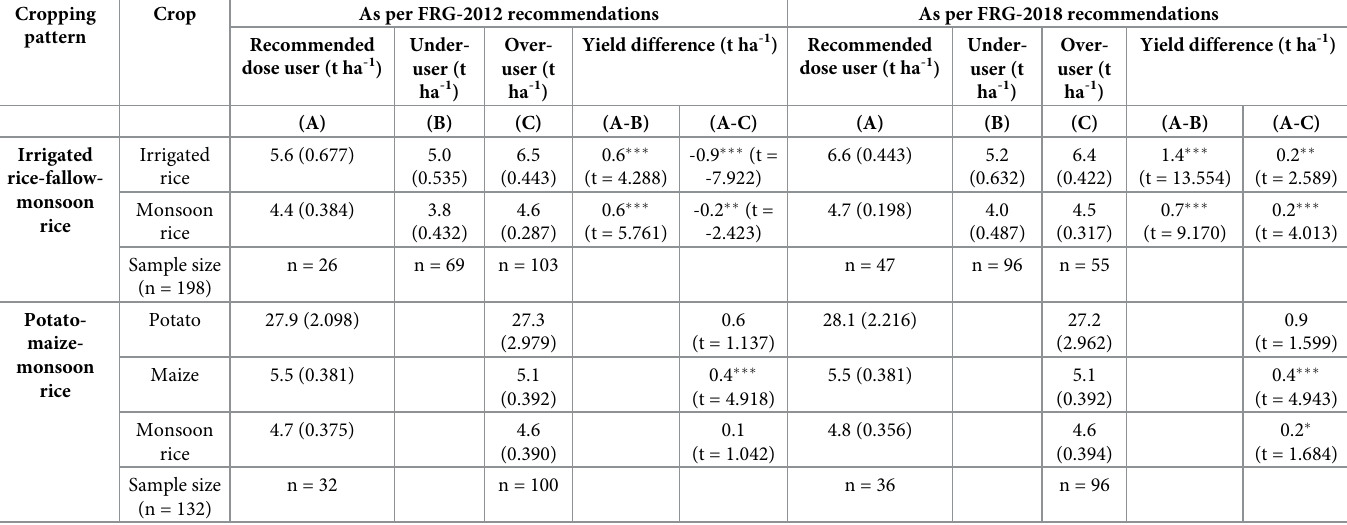
Table 5. Yield difference among different levels of nutrient users in the cropping season relative to Government-endorsed recommendations under diverse rice- based cropping patterns. Cropping